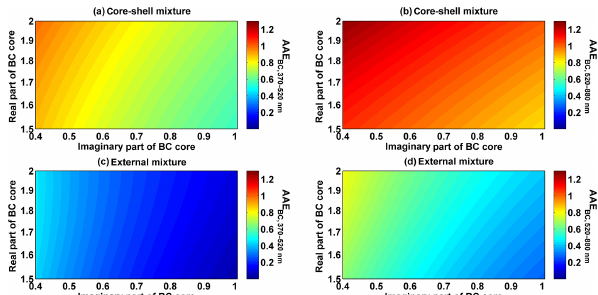
Figure 4. Influence of the wavelength-independent refractive in- dex of the BC core on AAEs with a constant shell refractive index ( e m shell = 1 . 55 − 10 − 7 i) . A core–shell mixture was used for panels a and b, and an external mixture was used for panels c and d. The real part of e m core varied from 1.5 to 2.0, with a step of 0.05, and the imaginary part of e m core varied from 0.4 to 1.0, with a step of 0.05.